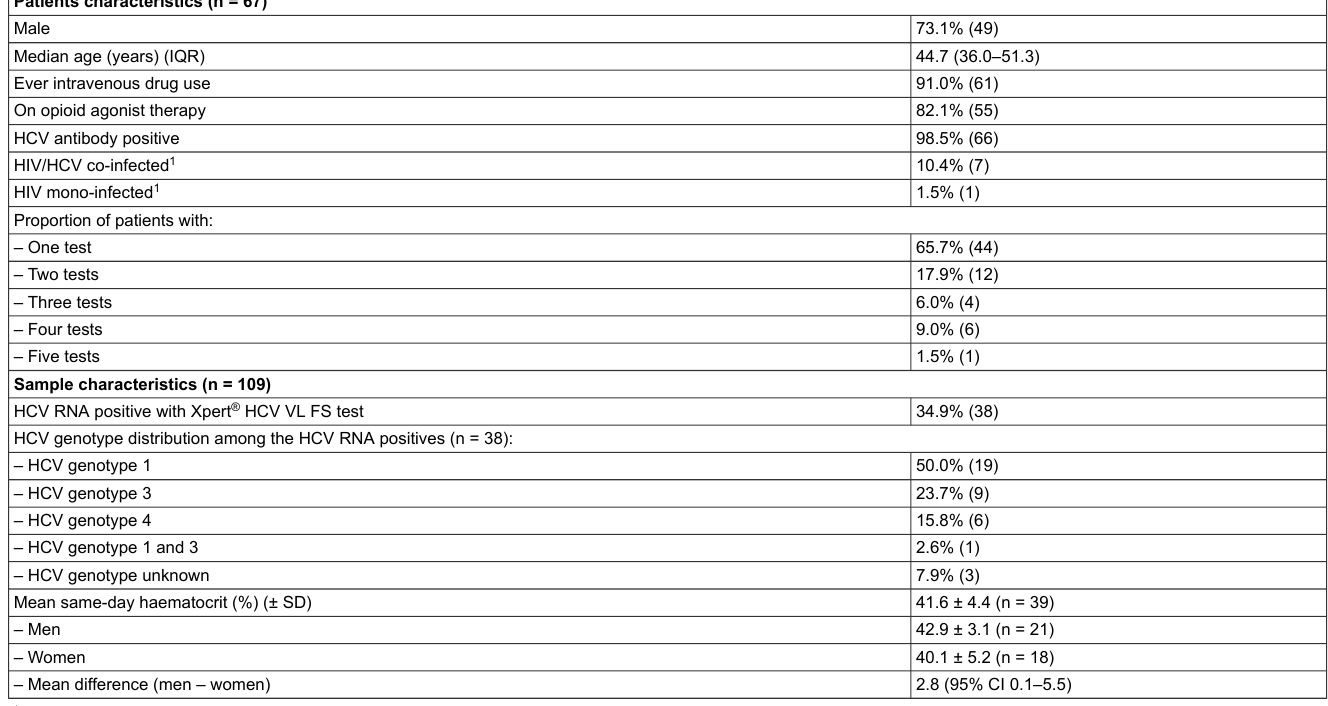
Table 1: Patient/sample characteristics. Patients characteristics (n = 67)